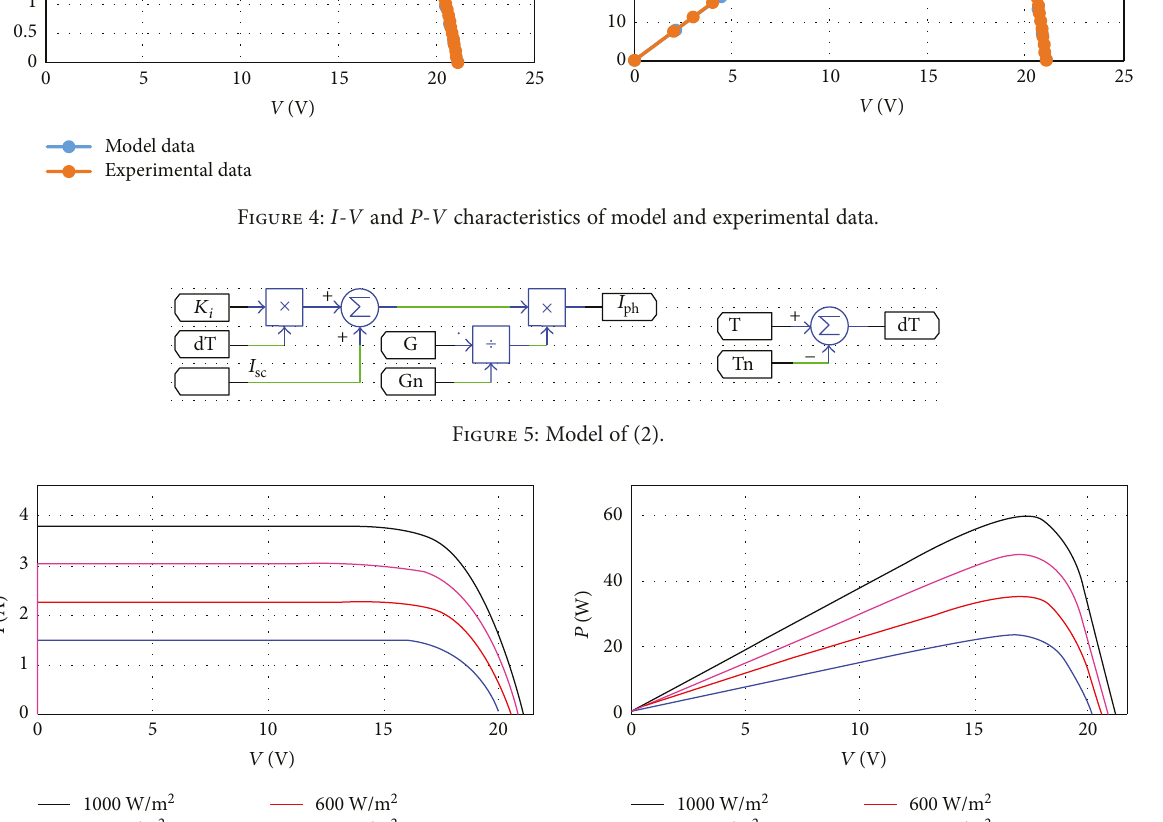
Figure 6: I ‐ V and P ‐ V curves for di ff erent values of irradiance.